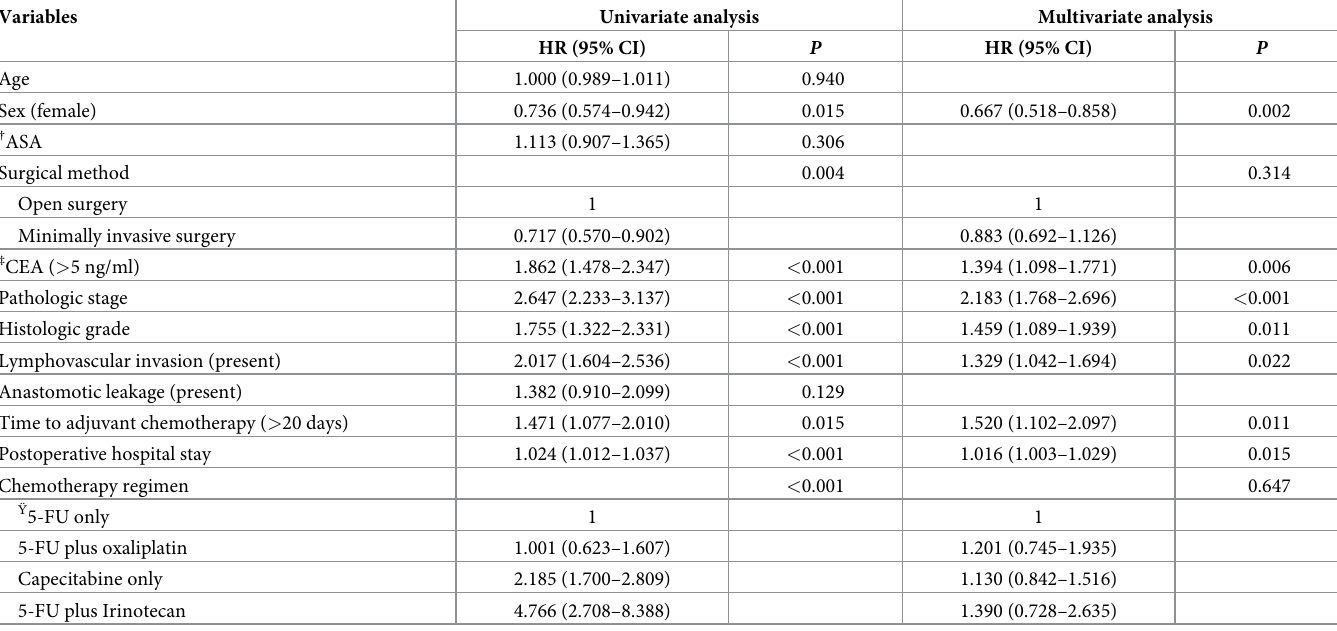
Table 2. Cox regression disease-free survival in all patients.